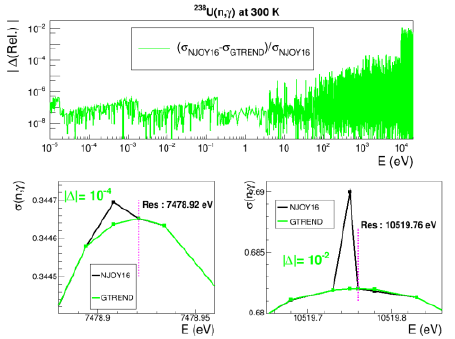
Fig. 3. Relative discrepancies on radiative capture cross-sections of U238 at 300 K